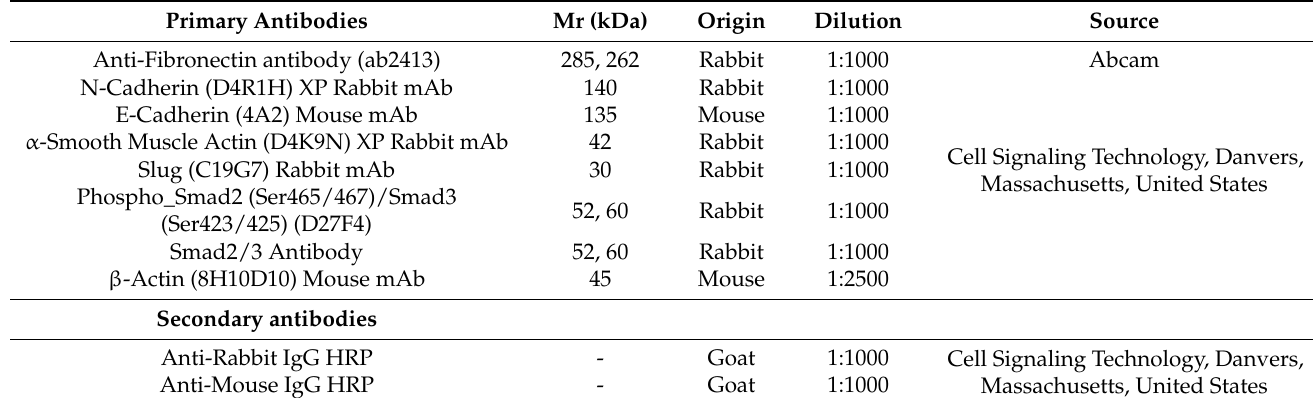
Table 1. List of Western blot antibodies.